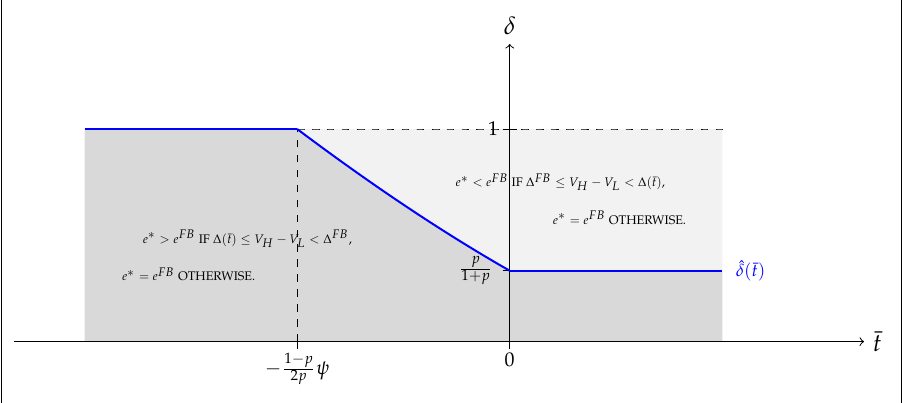
Figure 5. Second-best